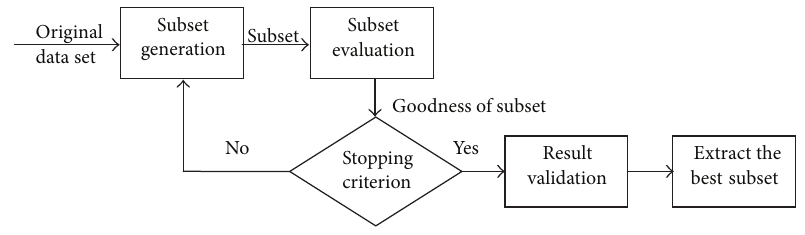
Figure 1: Key sequences of feature